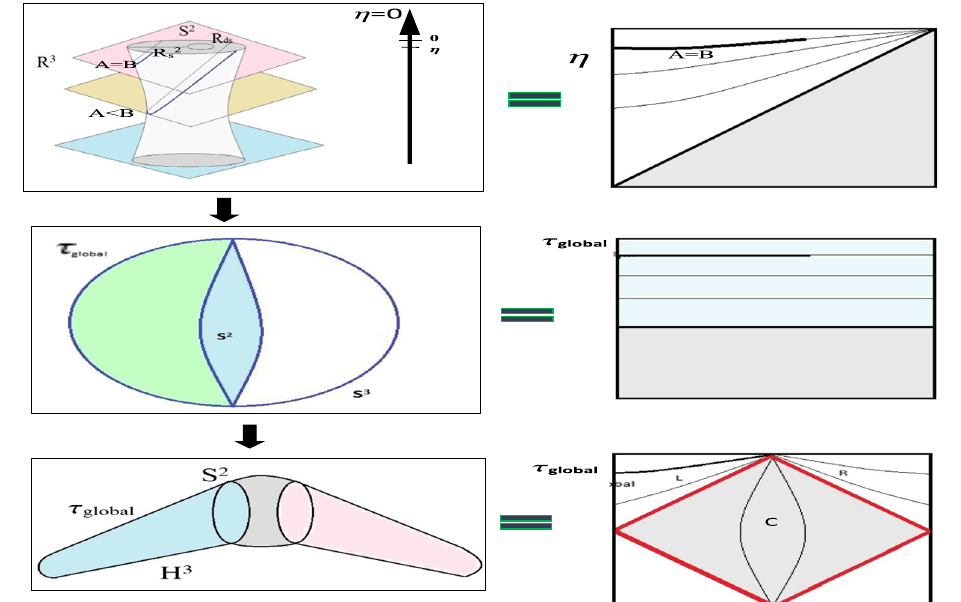
Fig. 2 Schematic diagram for the geometrical construction of the bipartite system. First we consider S 2 with radius R (cid:6) R dS = H − 1 , which at late global time τ global can mapped to half of a S 3 with bound-